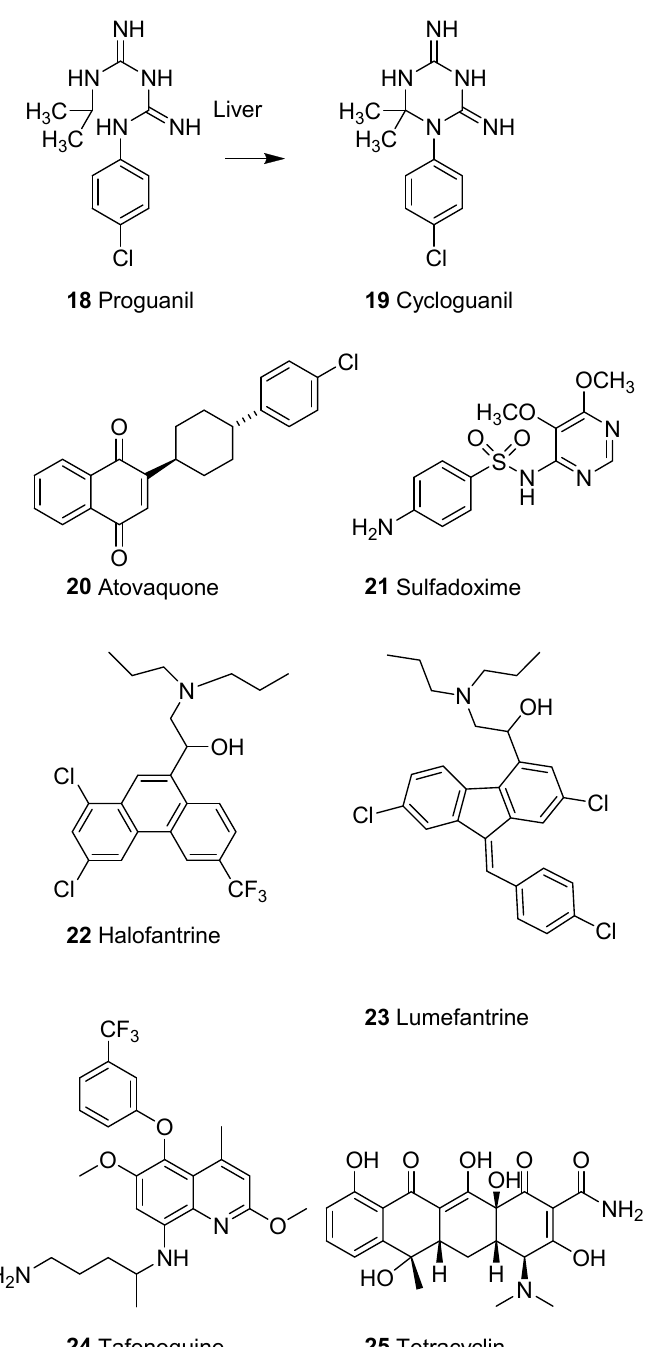
Figure 8. Antimalarial drugs. Except for tetracycline all the compounds are synthetic drugs. Proguanil, sulfadoxime, lumefanthrine and tetracycline are included in WHO list of essential medicines (https://www.who.int/medicines/publications/essentialmedicines/en/, accessed on 1 April 2021).